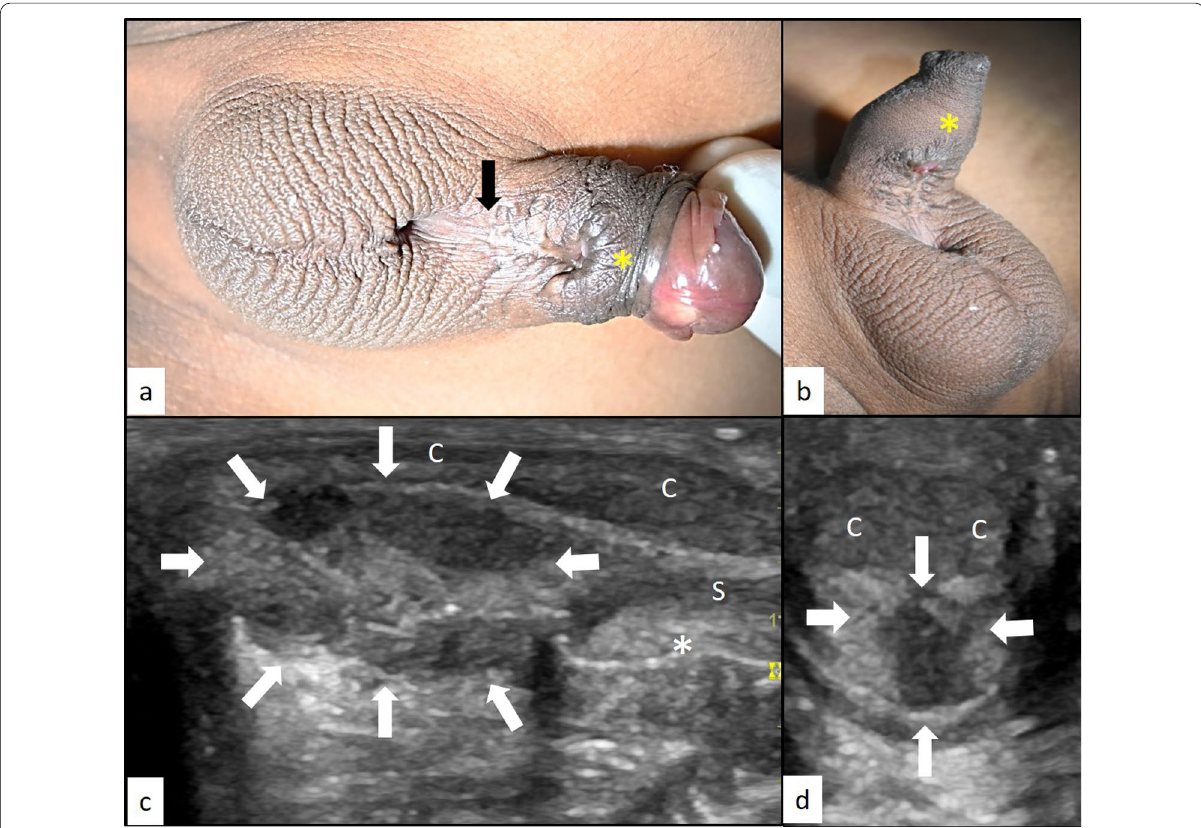
Fig. 4 Postoperative clinical photographs ( a , b ) after resection of the mass. Note the gap (arrow) between the urethrostomies and the distal penile urethra (yellow asterisk). Longitudinal ( c ) and transverse ( d ) sonographic gray scale images with the probe dorsal, shows post-operative changes (arrows) in the proximal penile shaft with non-visualization of the mass, corpus spongiosum and proximal urethra. Distal penile shaft shows normal urethra (asterisk) within the corpus spongiosum (S). C indicates corpus